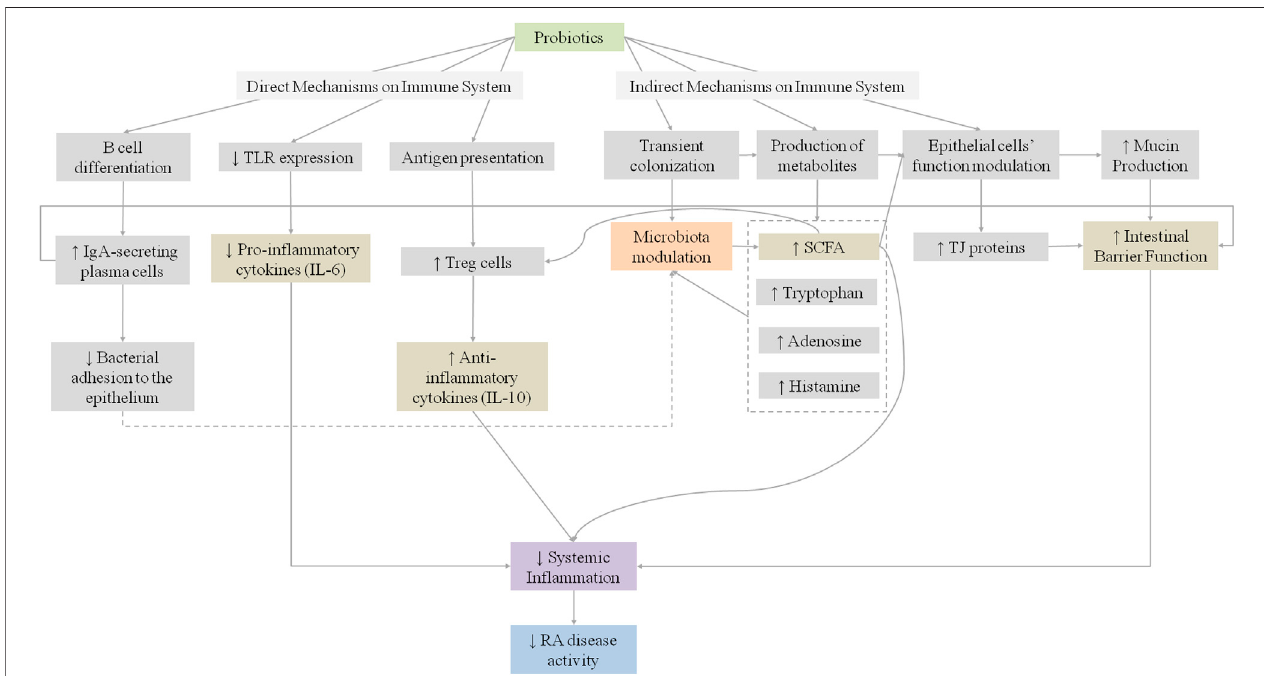
FIGURE 2 | Proposed mechanisms for the in fl uence of probiotics on systemic in fl ammation in rheumatoid arthritis patients. IgA, Immunoglobulin A; IL, Interleukin; RA, Rheumatoid; SCFA, short Chain Fatty Acids; TJ, Tight Junctions; TLR, Toll-like receptors.